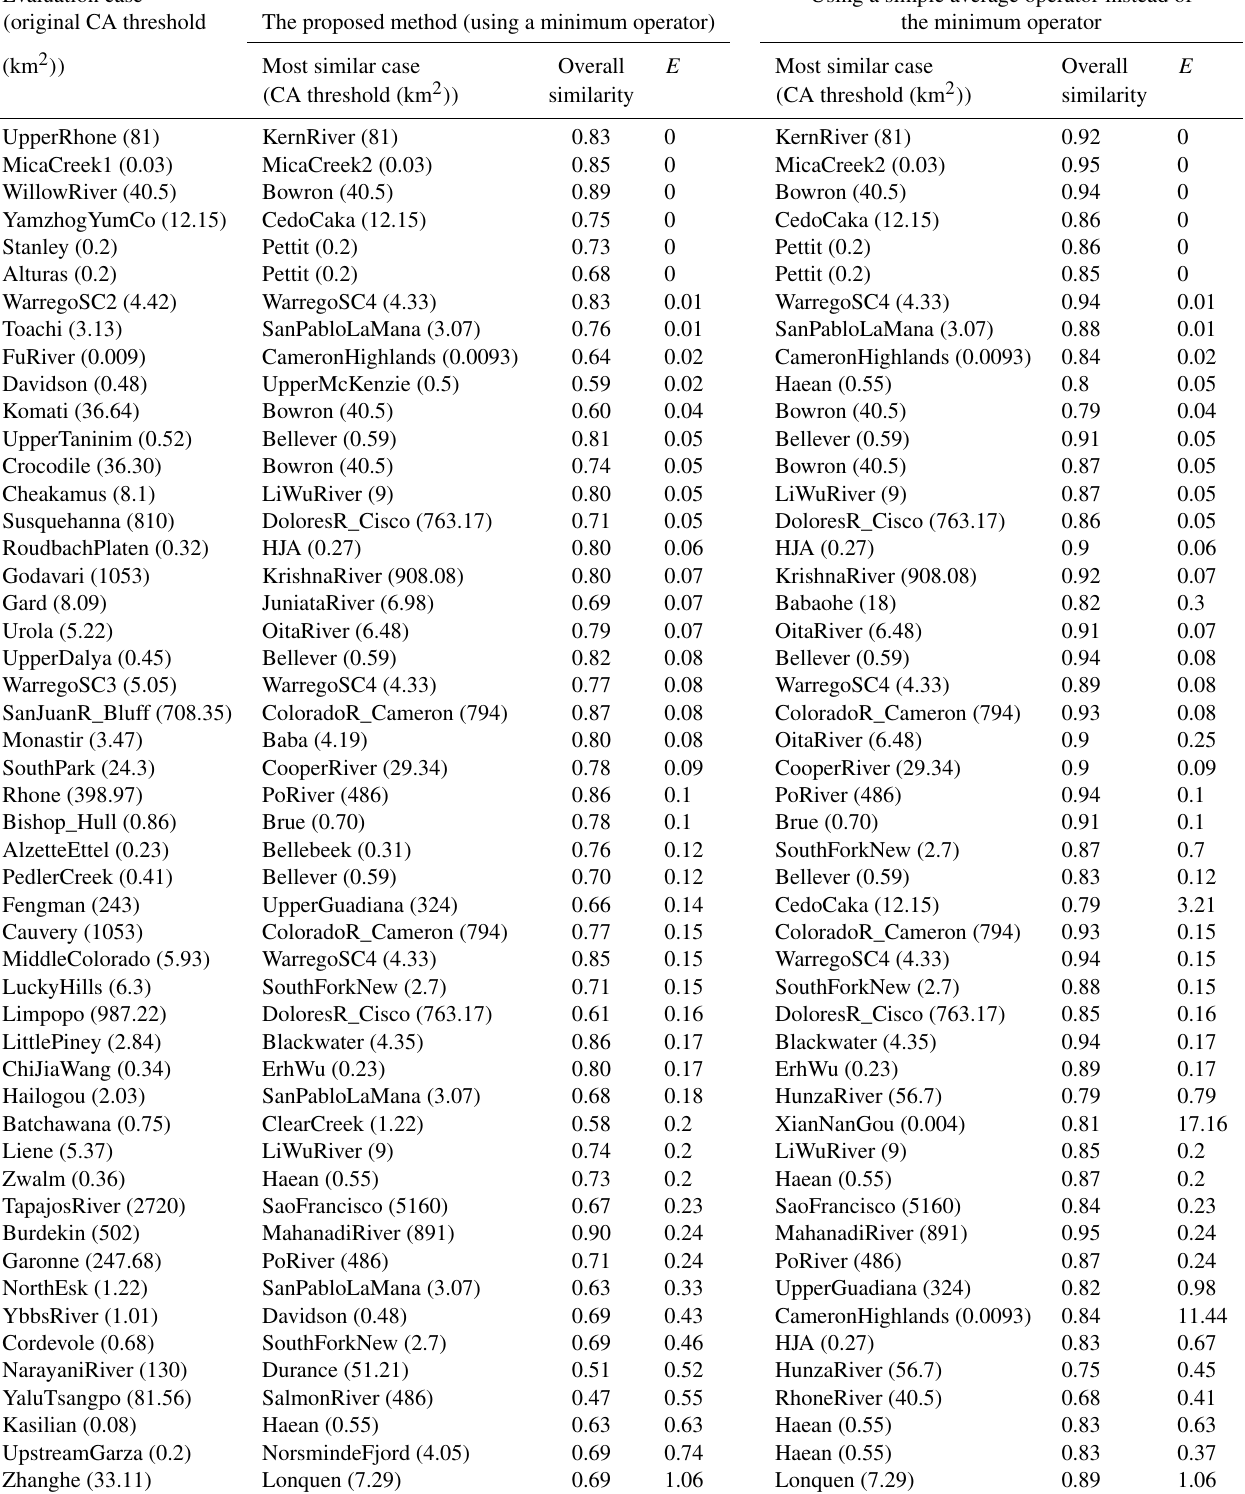
Table 3. Evaluation results of the proposed method (in order of E ) and the corresponding results when a simple average operator was used instead of the minimum